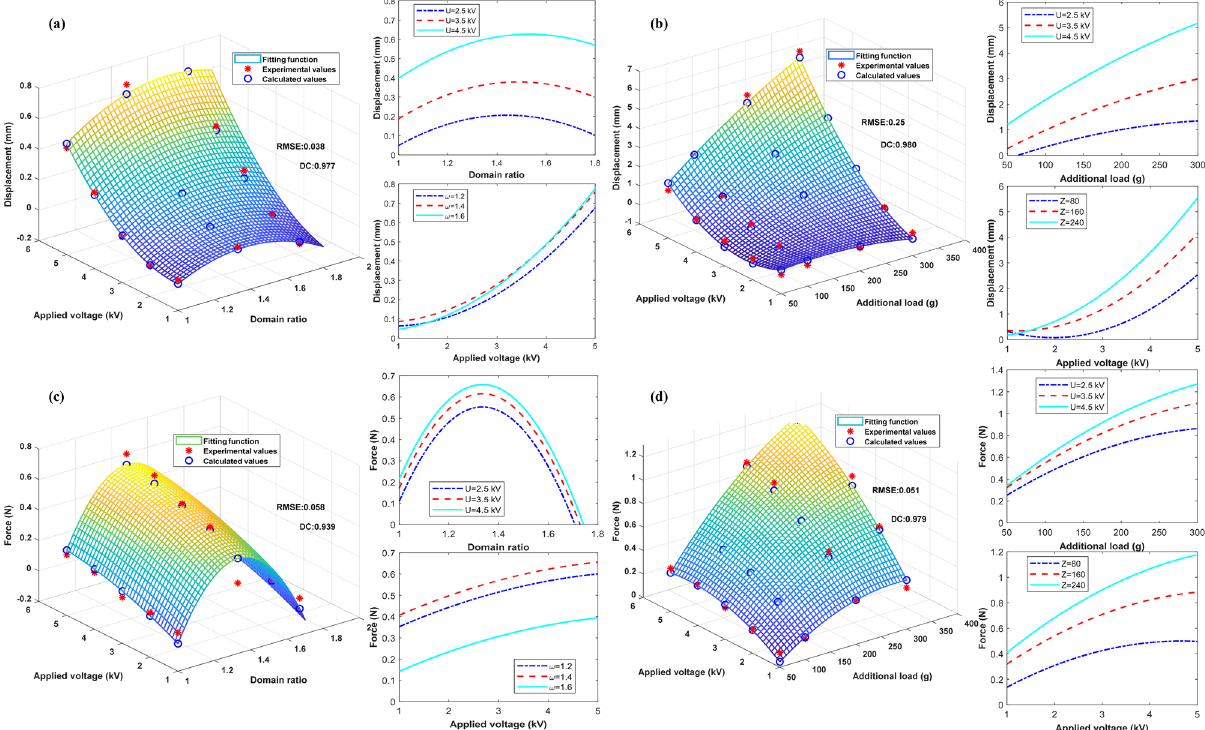
Figure 3: Three - dimensional model diagram for